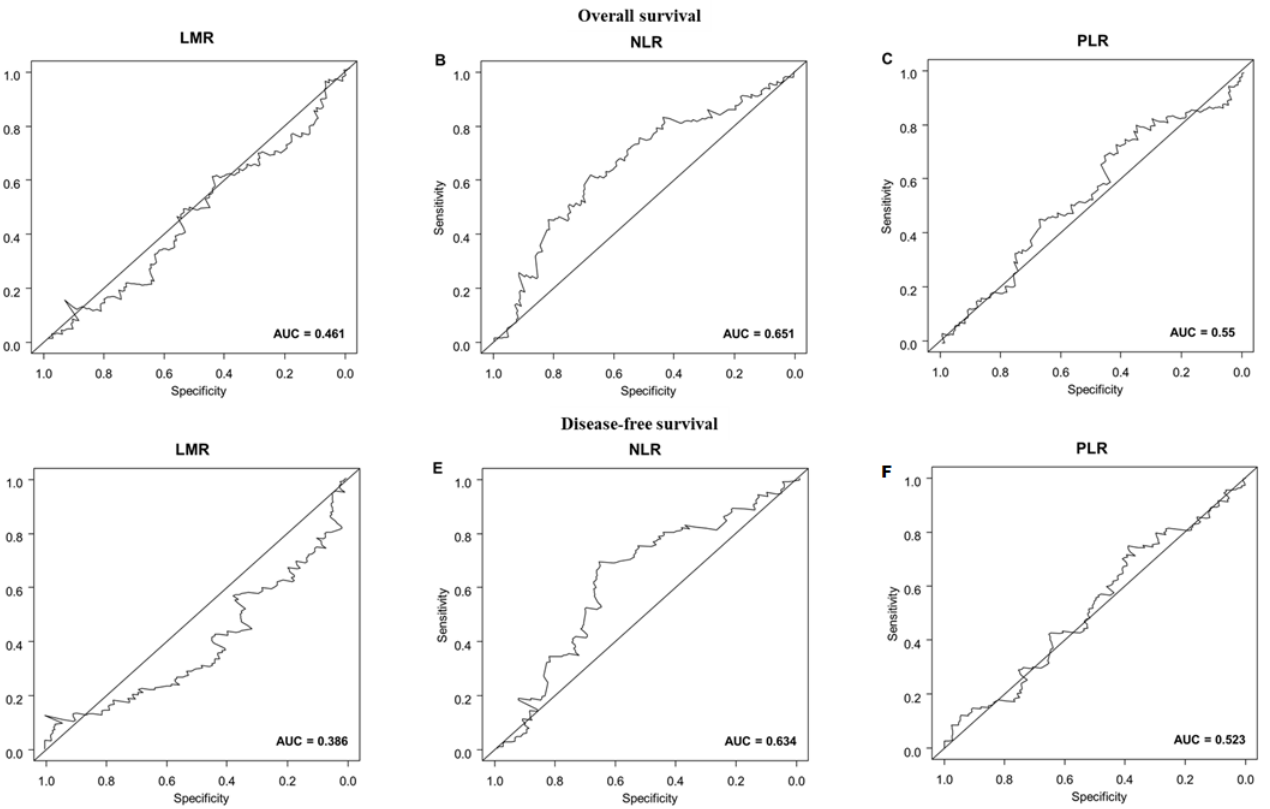
Figure 2. Time-dependent receiver operating characteristic curves for determining the optimal cut-off value of preoperative systemic inflammatory markers for overall survival (( A ) Lymphocyte-to-monocyte ratio, ( B ) neutrophil-to-lymphocyte ratio, and ( C ) platelet-to-lymphocyte ratio) and disease-free survival (( D ) Lymphocyte-to-monocyte ratio, ( E ) neutrophil-to-lymphocyte ratio, and ( F ) platelet-to-lymphocyte ratio). Table 4. Univariate analysis of prognostic factors of overall survival and disease-free survival using Cox regression model.